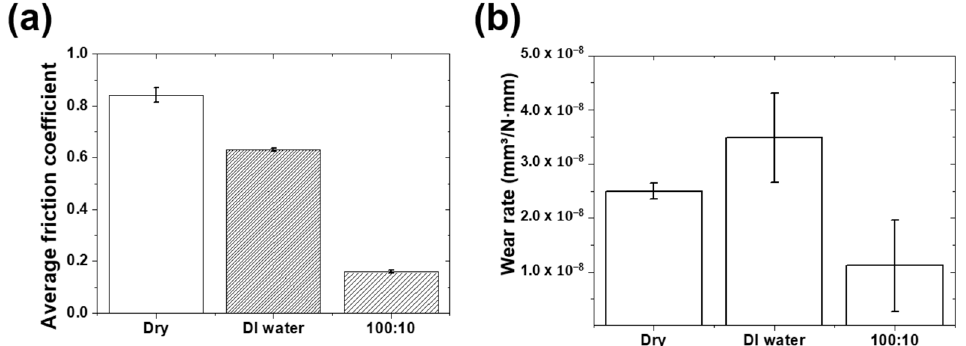
Figure 4. Friction and wear characteristics of graphene coated stainless steel under 200 mN normal loads during 100,000 cycles. ( a ) average friction coefficient; ( b ) wear rate.